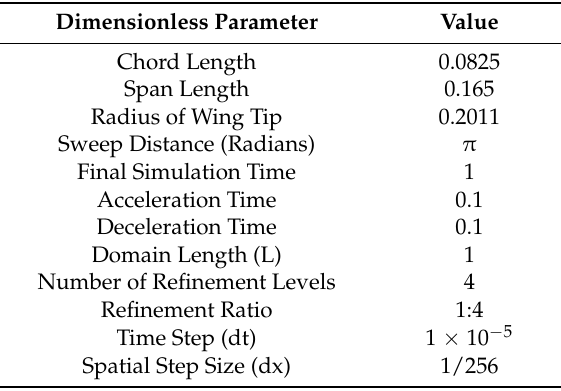
Table 1. The numerical parameters. Lengths are nondimensionalized by the length of the domain and time by the total time it takes to rotate π radians.